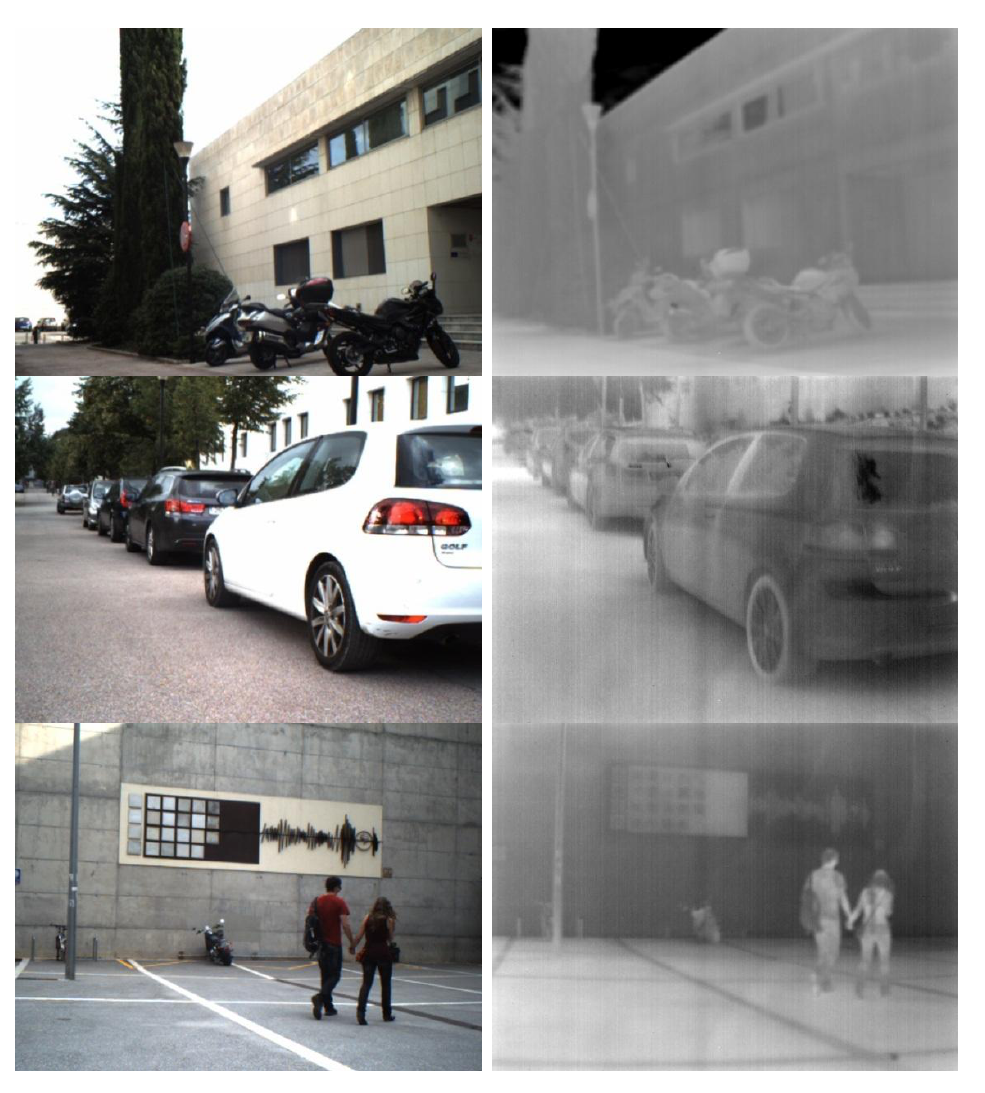
Figure 2. Pairs of cross-spectral images contained in the data